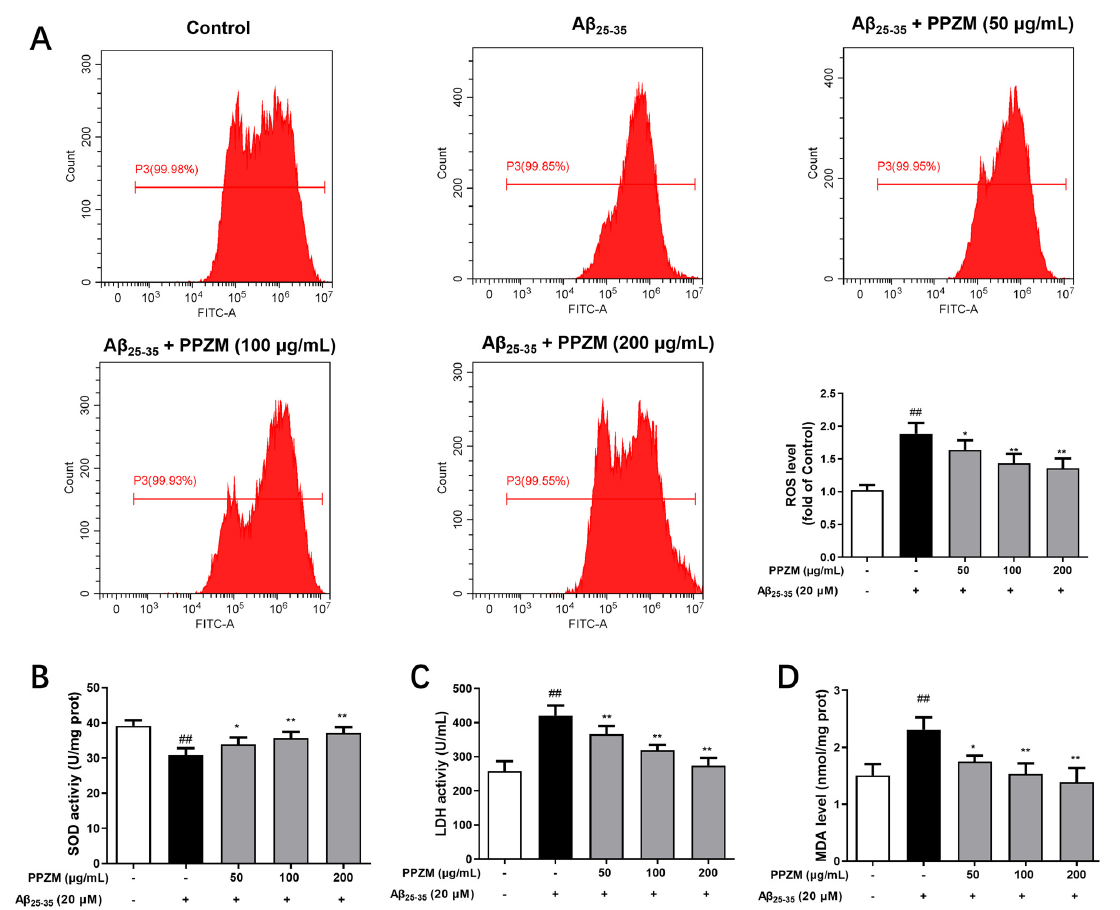
Figure 5. Effects of PPZM on A β 25–35 -induced oxidative stress in PC12 cells. ( A ) ROS level deter- mined by DCFH-DA staining. The levels of SOD ( B ), LDH ( C ), and MDA ( D ) measured by using ELISA kits. Results are expressed as the mean ± SD. ## p < 0.01 vs. the control group; * p < 0.05, ** p < 0.01 vs. the A β 25–25 treated group.